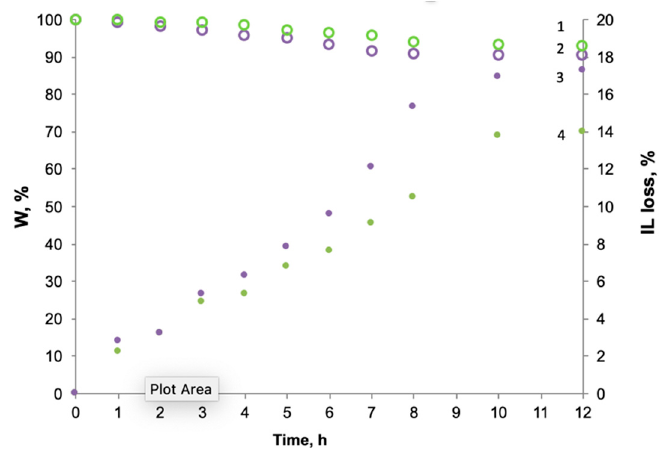
Figure 4. Membrane weight fraction W (1—bmim[OAc], 2—bmim[BF 4 ]) and an ILs loss (3—bmim[BF 4 ], 4—bmim[ace]) and as a function of time.